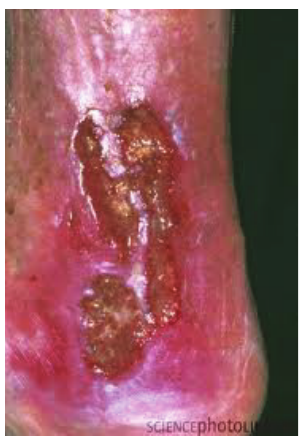
Figure 1: Venous leg ulcers are usually located in the “gaiter” region of the leg as shown in the image above. They have certain characteristics: (i) ruddy coloured base, (ii) large area, (iii) shallow depth, (iv) irregular wound margins, (v) moderate to heavy exu- dates, (vi) pitting or nonpitting oedema, (vii) granulation tissue, (viii) warm skin temperature, and (ix) pulses present with normal capillary refill of less than 2 seconds [13]. Some of these can affect the rate of wound healing. They can be associated with other signs of venous hypertension such as varicosities, haemosiderin pigmentation, atrophy blanche, and varicose eczema [13,